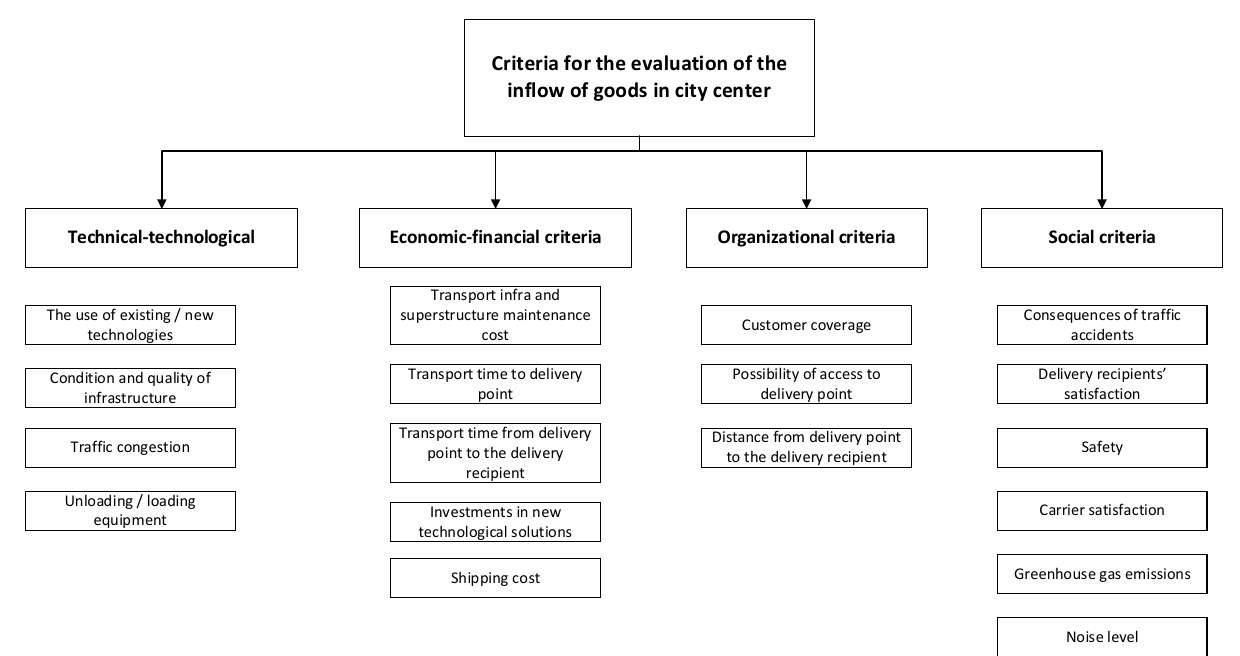
Figure 1. Evaluation criteria. Source: authors.